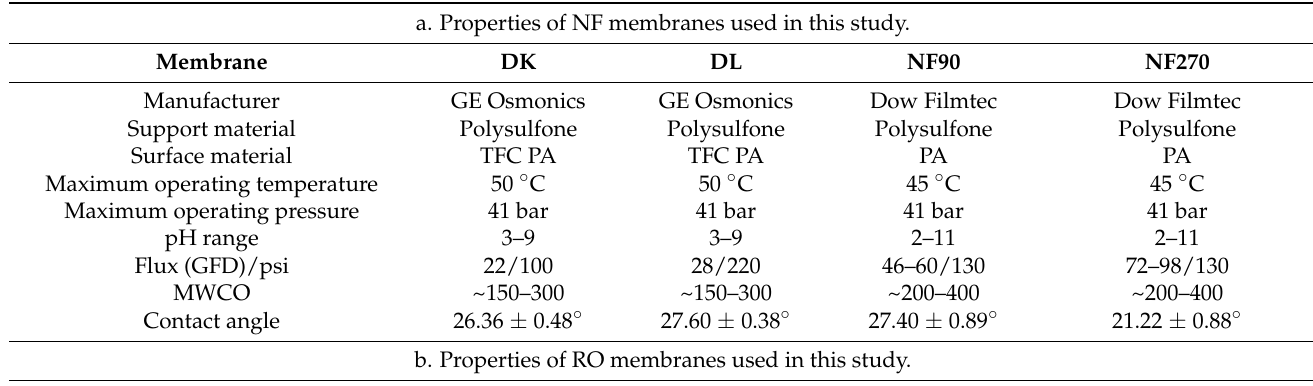
Table 3. Characteristics and supporting information for the membranes used in this study. a. Properties of NF membranes used in this